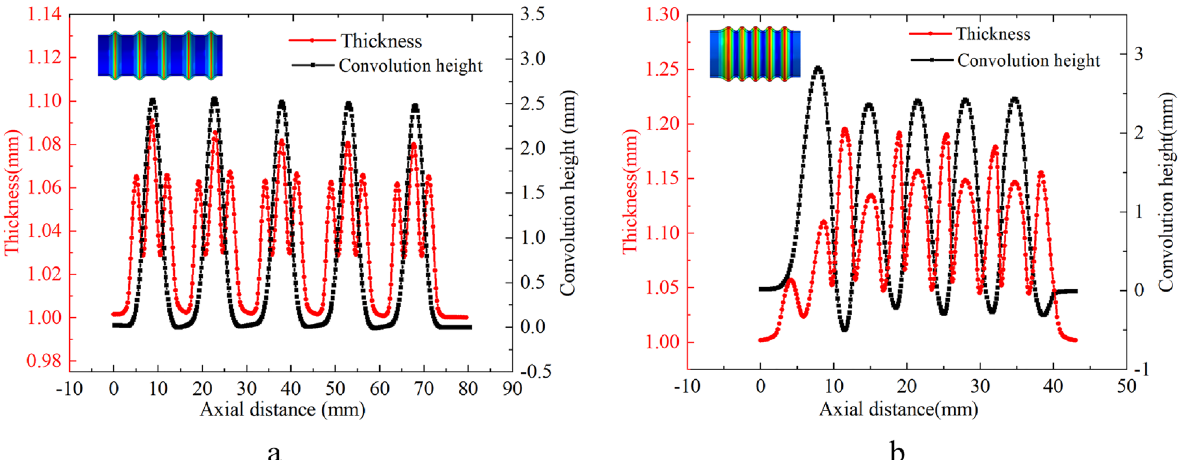
Figure 7 a Curves of wall thickness and convolution height of the discontinuous bellow, b Curves of wall thickness and convolution height of the continuous bellow